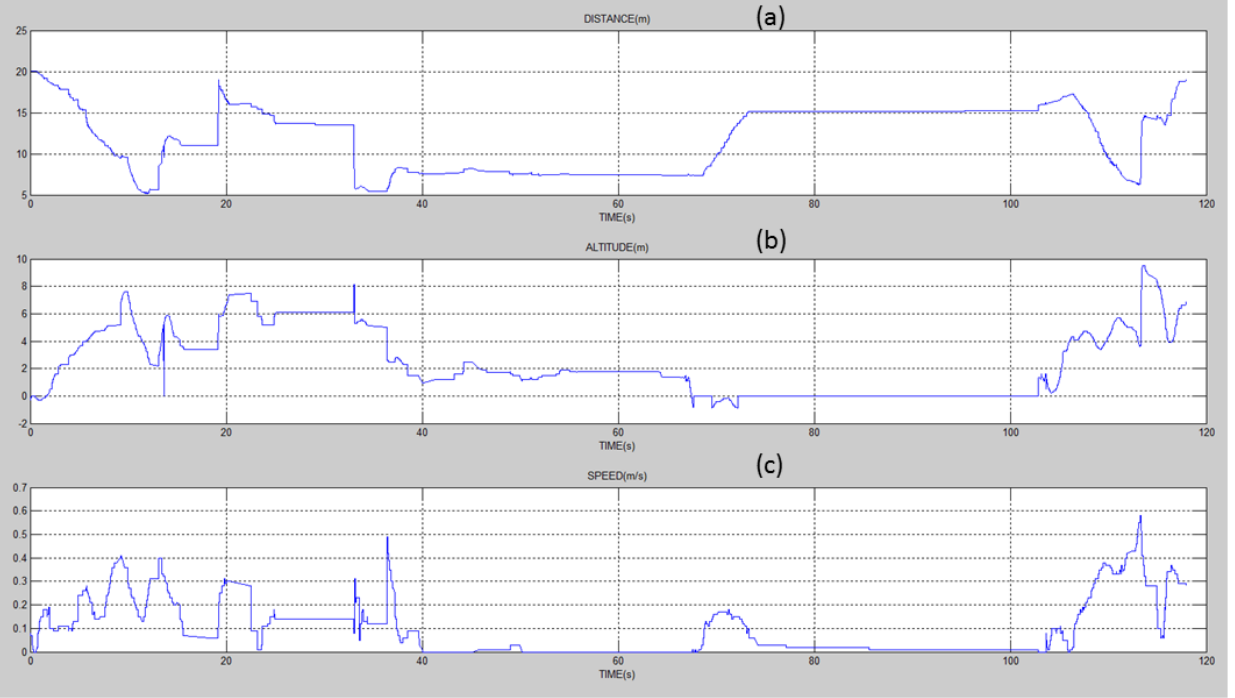
Figure 4. UAV experiment flight log with respect to ( a ) distance; ( b ) altitude; and ( c )